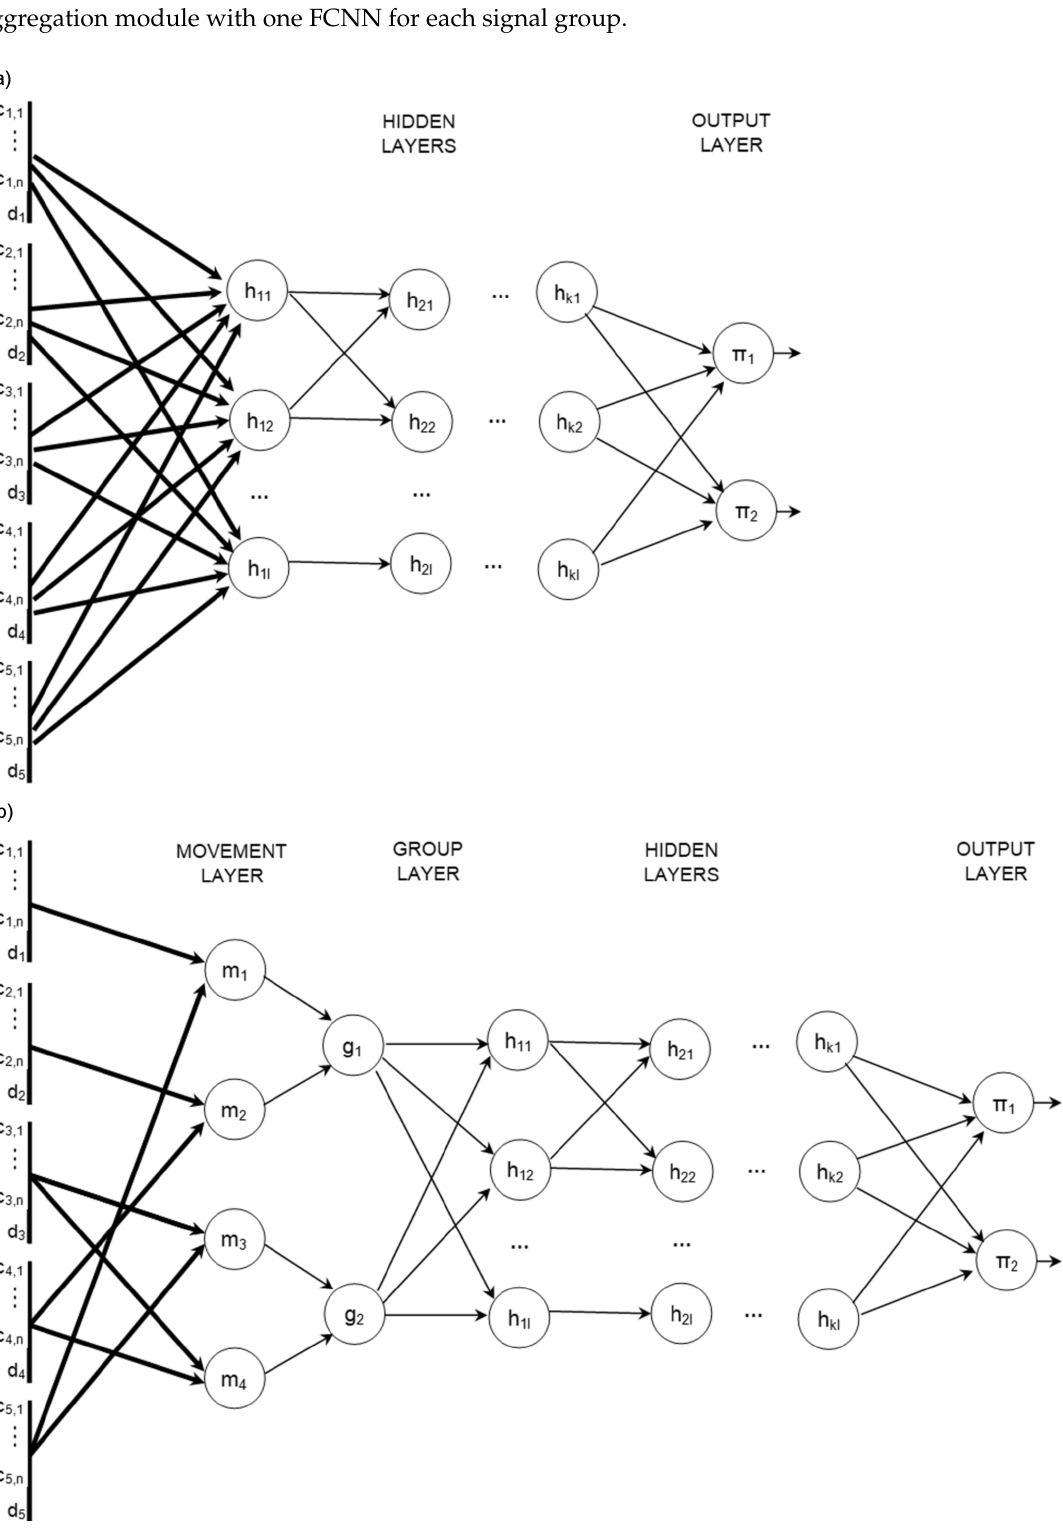
Figure 13. Topologies of the compared ANNs: ( a ) ANN_SW/DW, ( b )